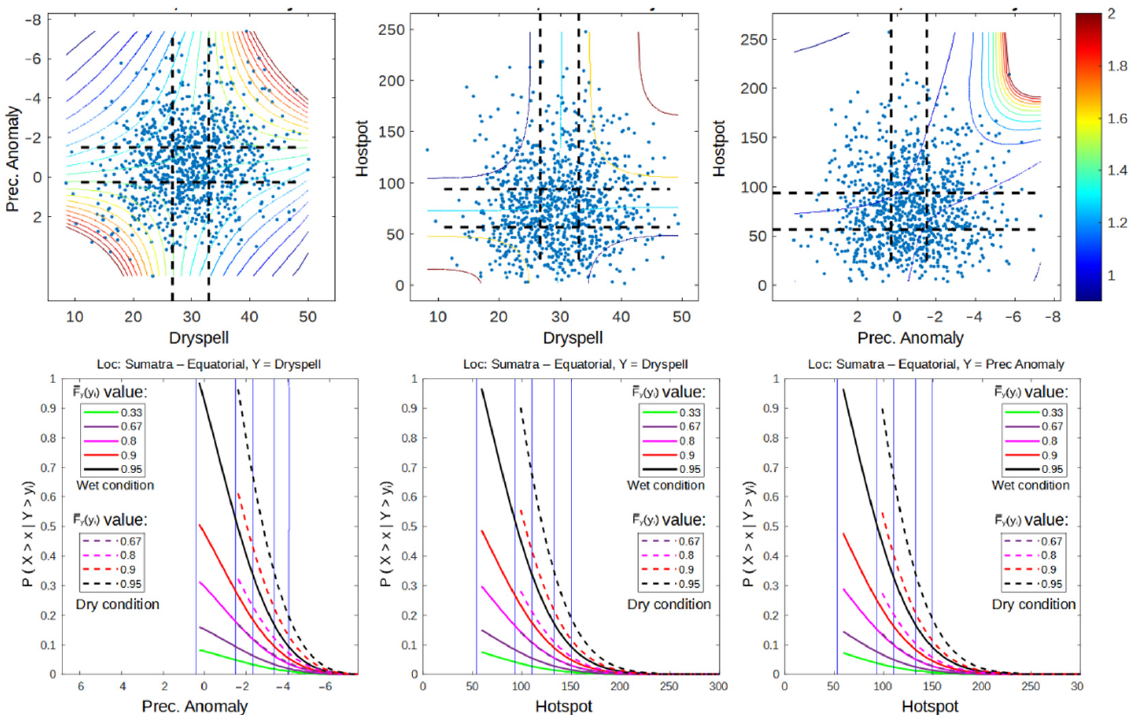
Figure 10. Dependency graph of each variable pair as well as conditional probability of 5% upper right quadrant from all observed data (January 2001–December 2020) on Sumatra with equatorial-type precipitation (2nd dry season: June–September).